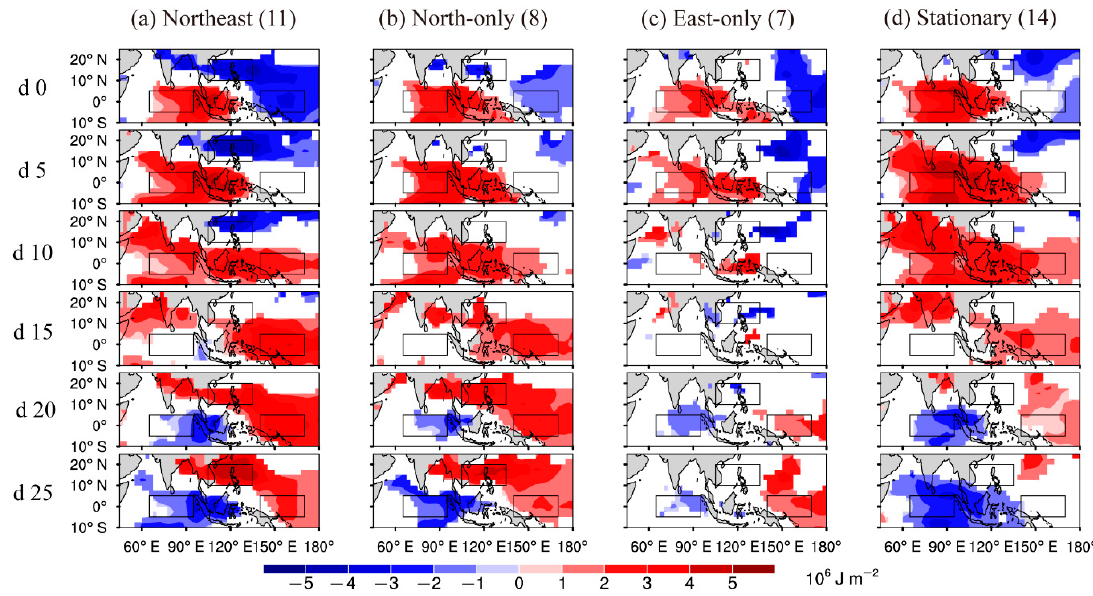
Figure 4. Spatial–temporal moist statistic energy (MSE) evolution characteristics of the four modes. Evolution of column-integrated MSE anomalies (10 6 J m − 2 by lagged regression against 30–90-day bandpass-filtered OLR anomaly averaged over the EIO from day 0 to day 25 for ( a ) northeast mode, ( b ) north-only mode, ( c ) east-only mode, and ( d ) stationary mode. Only anomalies above 90% significance by Student’s t test are plotted.